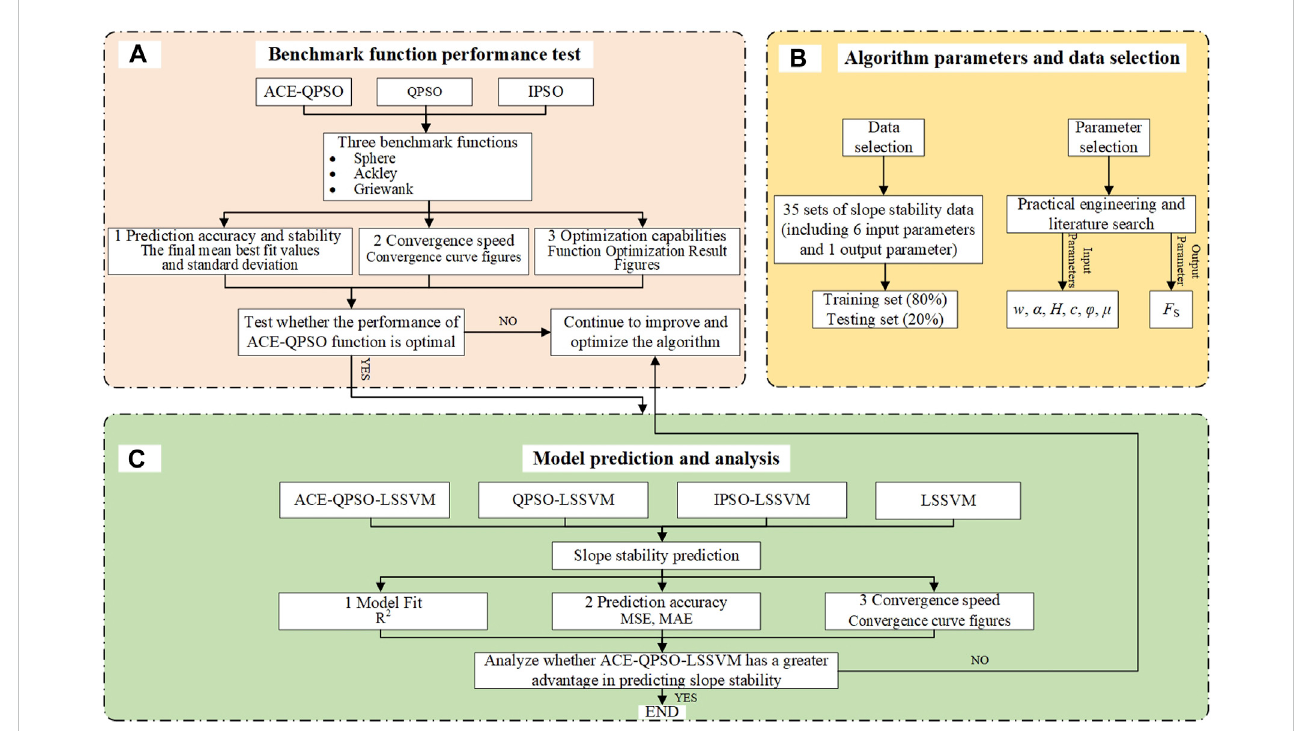
FIGURE 1 The modeling fl ow chart of slope stability prediction based on ACE-QPSO-LSSVM: (A) Benchmark function performance test, (B) Algorithm parameters and data selection, (C) Model prediction and analysis.